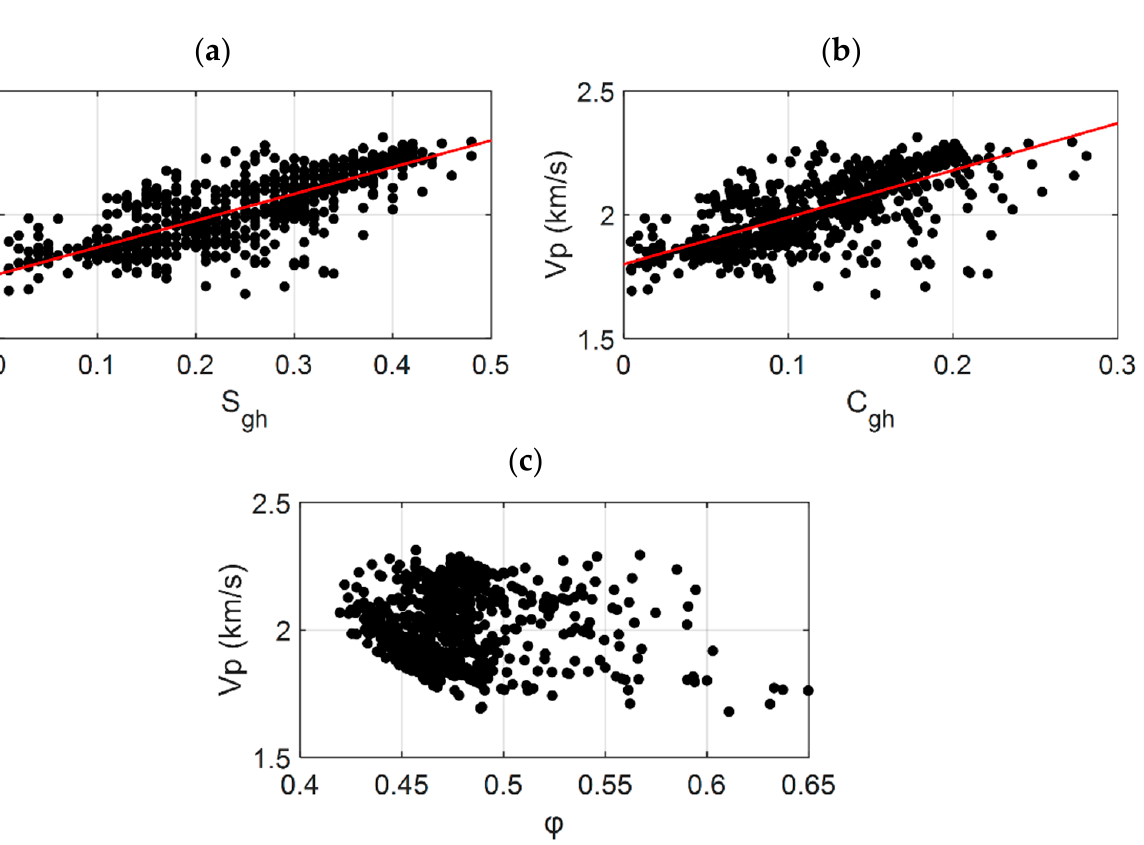
Figure 13. Correlation analyses of V P versus ( a ) S gh , ( b ) C gh , and ( c ) ϕ from the estimated results in Figure 11.